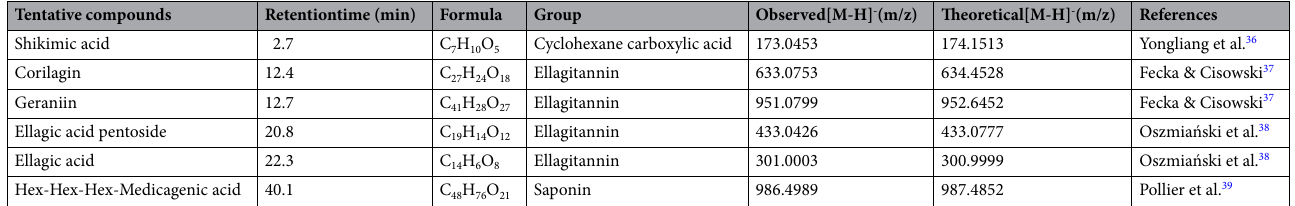
Table 6. Major phenolic compounds in rambutan peel crude